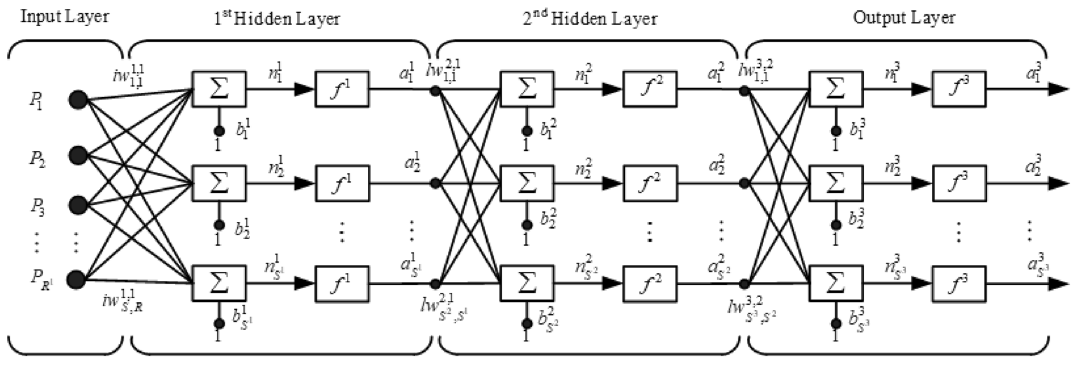
Figure 9. BPNN used in proposed